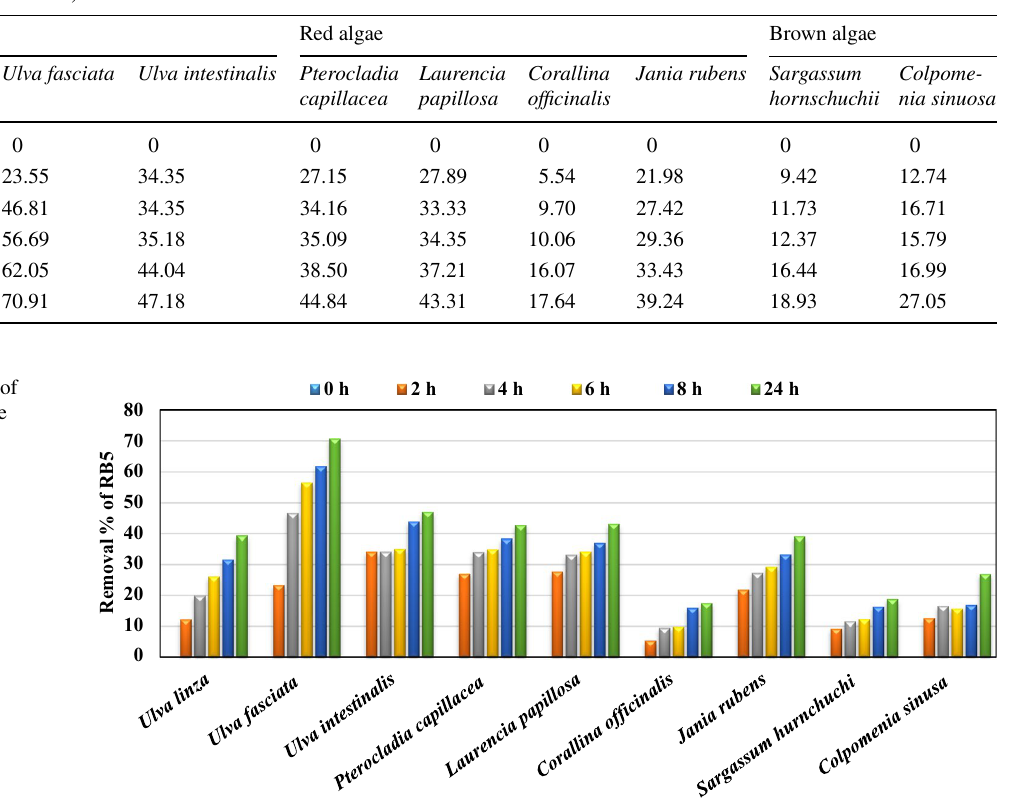
Table 6 Removal percentage of Reactive Black 5 (RB5) by the nine studied dried algal species Removal % of RB5 (λmax = 595 nm) Algae